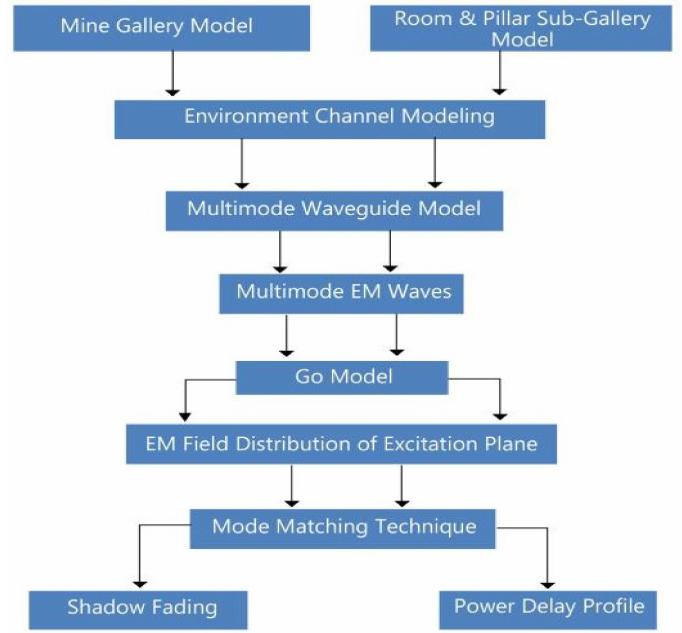
Figure 3. Flow diagram of proposed hybrid channel-modeling scheme for mines.